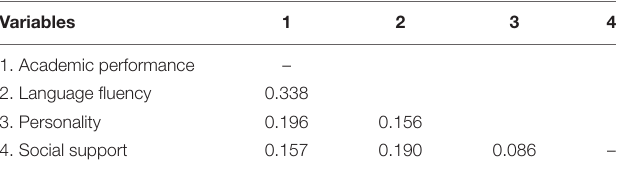
TABLE 4 | Heterotrait-Monotrait Ratio